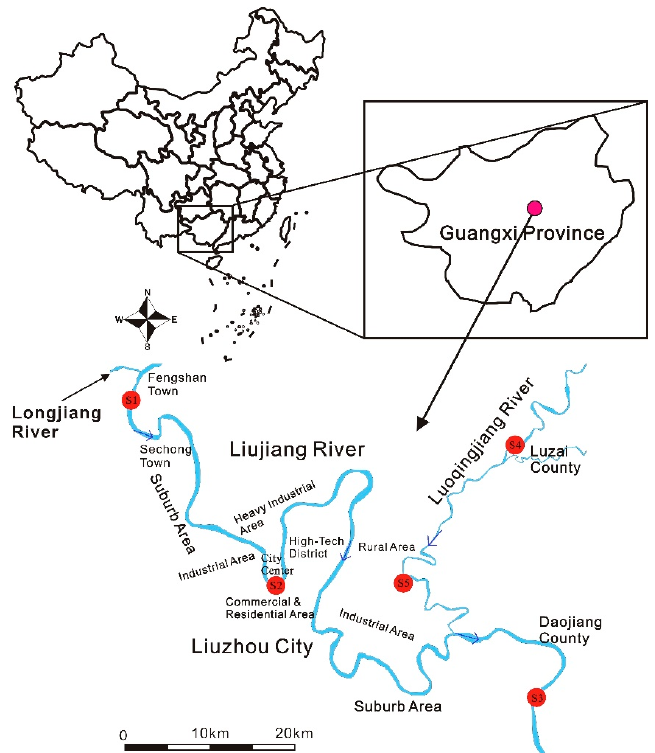
Figure 1. Study area with the five sampling sites along the Liujiang River and its tributary the Luoqingjiang River. Table 1. Details about the fish collected from the Liujiang River and its tributary the Luoqingjiang River.